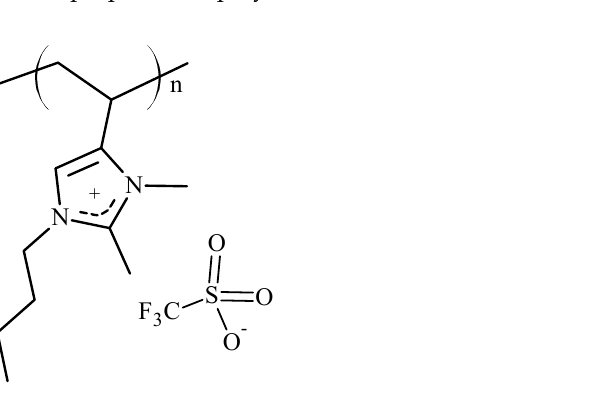
Figure 2. Structure of poly(1-butyl-2,3-dimethyl-4-vinylimidazolium triflate).